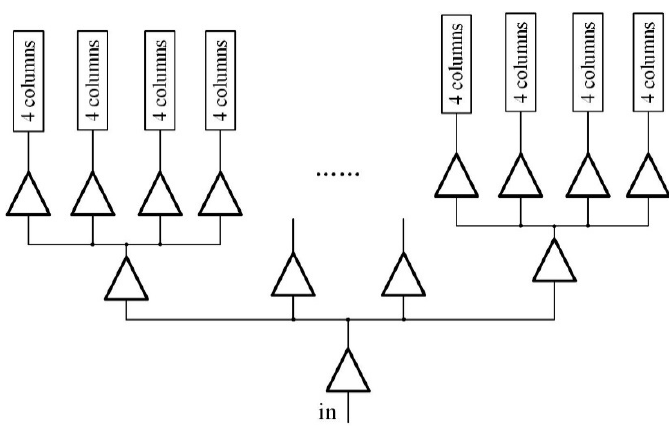
Figure 6. Schematic of the CTA.